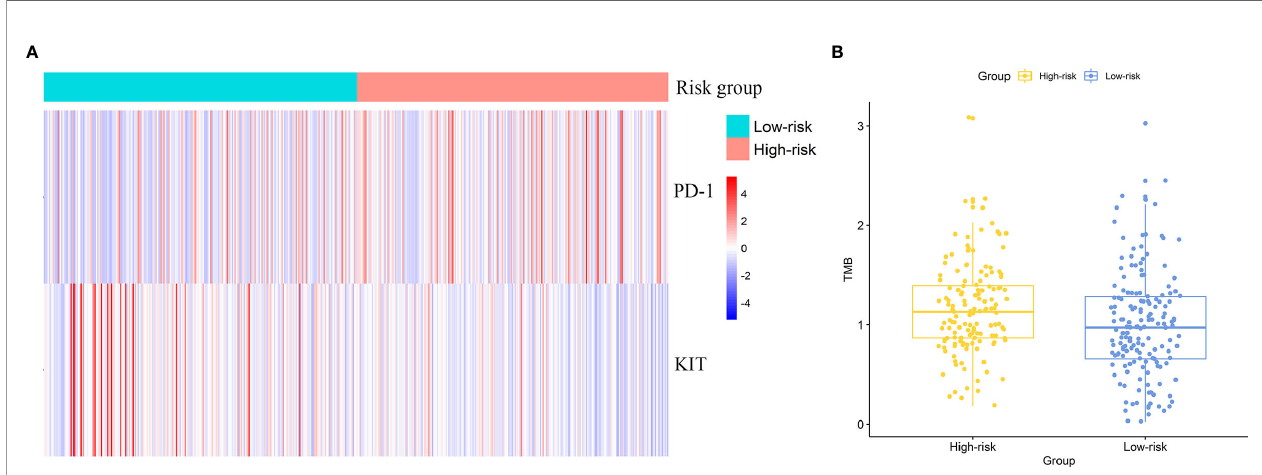
FIGURE 6 | Effectiveness prediction of precise treatments with our risk signature. (A) Differentially expressed targets for precise treatments. (B) TMB analysis of ccRCC patients and signi fi cant differences between high-risk and low-risk